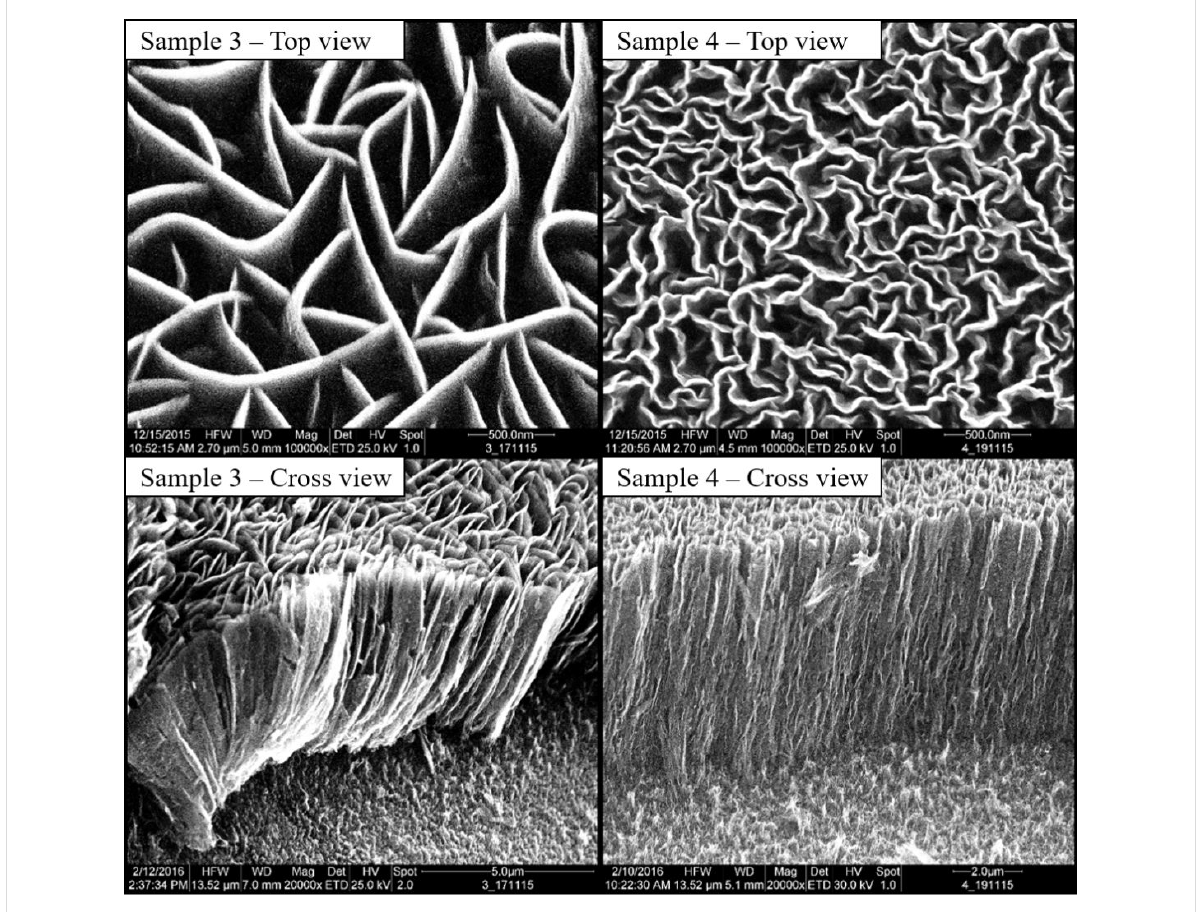
Figure 4: SEM images. Sample 3 deposited at 425 °C and − 30 V bias voltage: straight CNWs; sample 2 deposited at 500 °C and 0 V bias voltage: curled CNWs. All grown on silicon substrates. Cross-section images taken under from an angle of 45°.